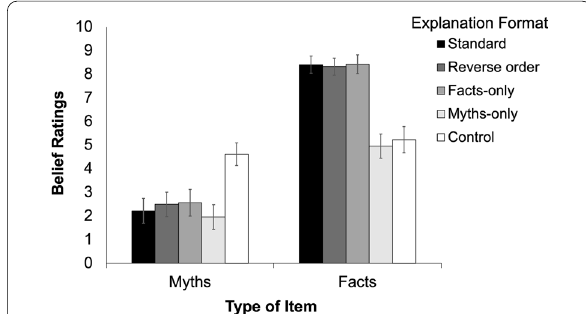
Fig. 3 Inference scores across conditions in Experiment 3. Error bars denote 95% confidence